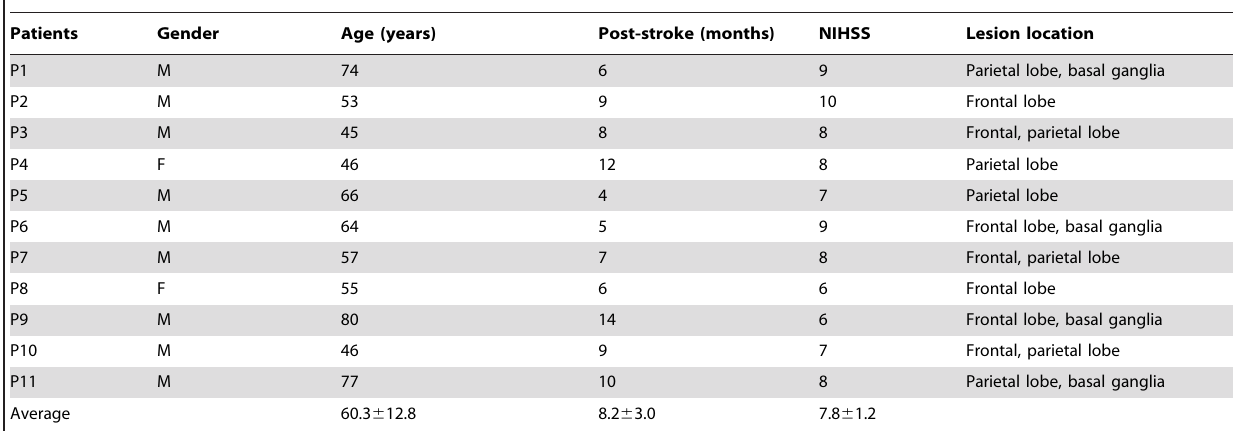
Table 1. Demography of stroke patients.